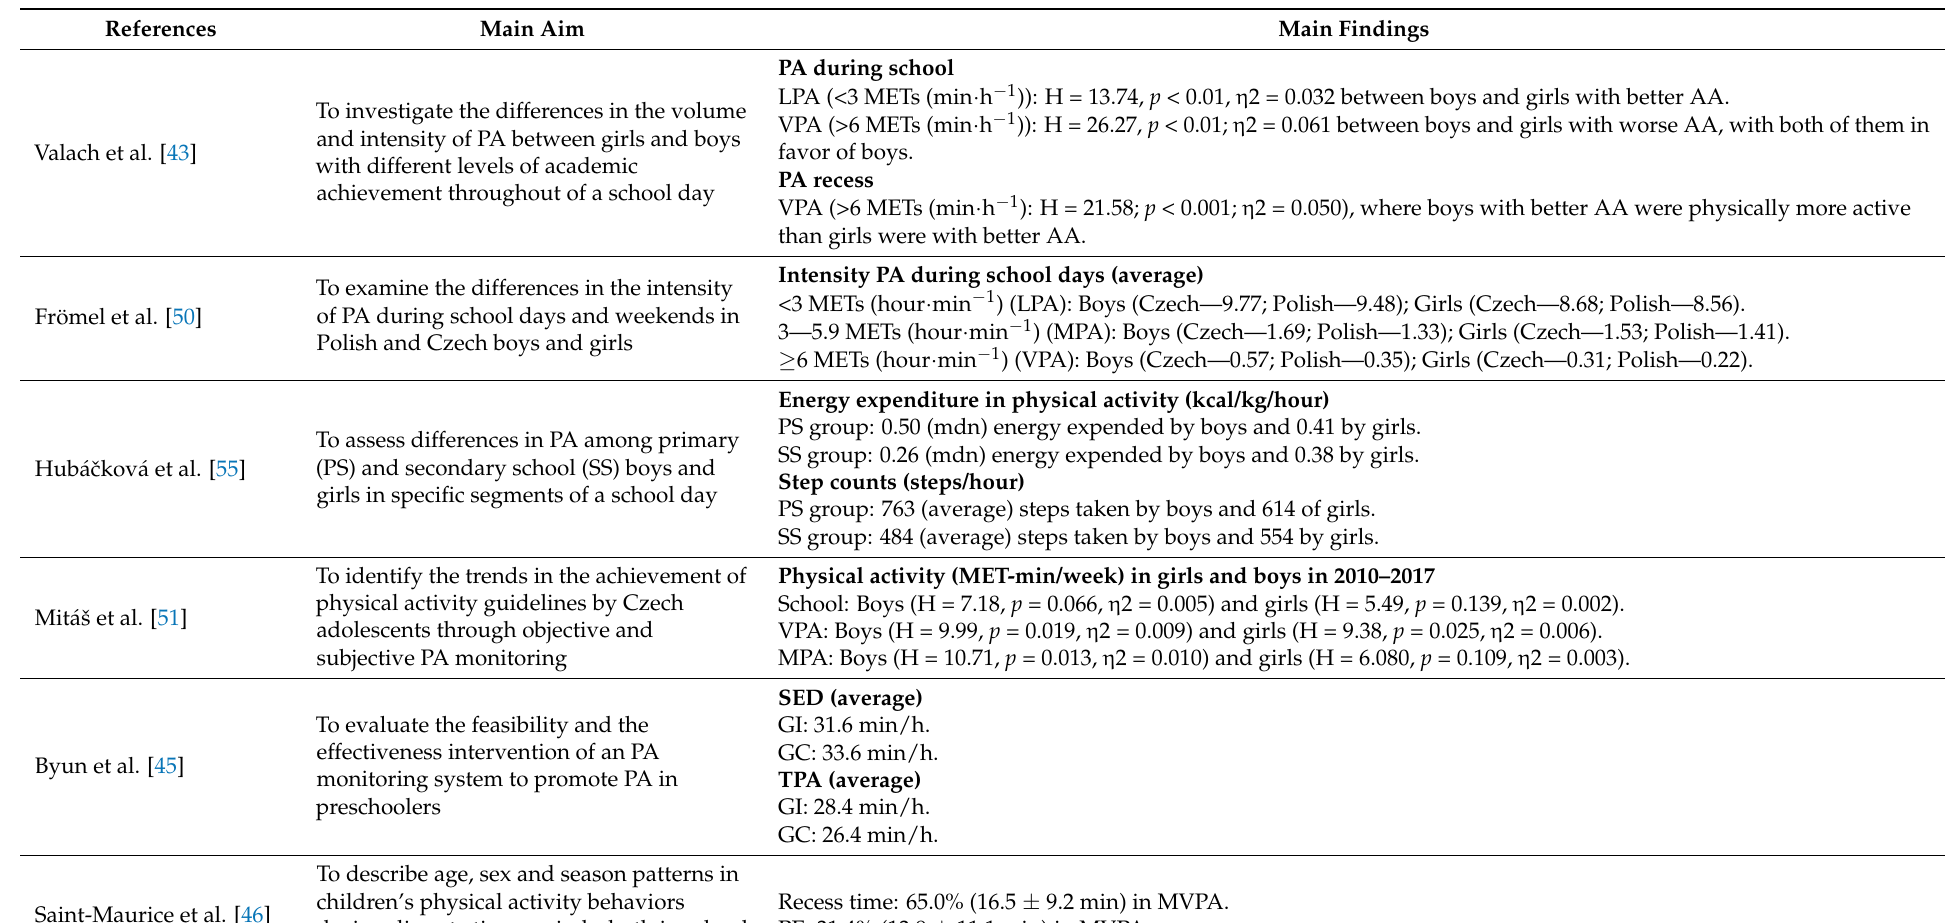
Table 3. Analysis of the main results of the studies included in the